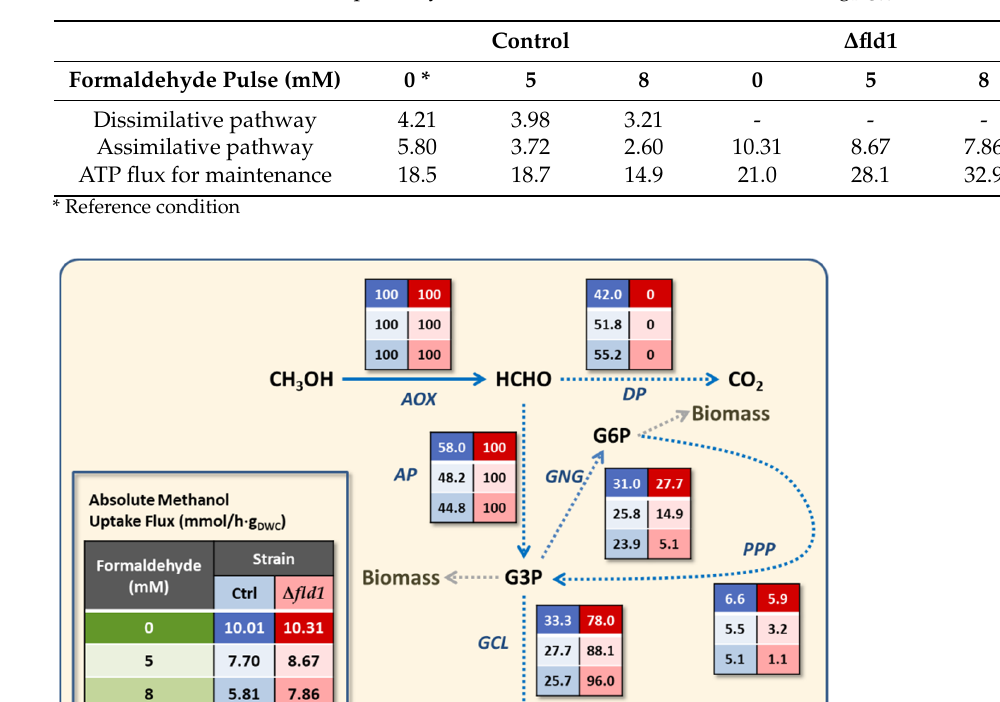
succinyl conezyme A; Mal: malate; OA: oxaloacetate. In order to confirm if the energy demand is increased by the lack of a dissimilative pathway, we have calculated the flux of ATP for maintenance by including the consump- tion and/or production of ATP (or GTP), NAD (P) H and FADH 2 in the metabolic reactions of the stoichiometric model. The estimation of the energy associated with maintenance has been used in several modelling approaches in yeast, including stoichiometric models to represent the metabolic processes that are occurring in the cell for viability and mainte- nance of homeostasis [18,20,28]. Results show that the ATP flux for maintenance was not affected by 5 mM formaldehyde pulses in the control strain, while a 20% reduction was observed after the 8 mM formaldehyde pulse (Table 3). In contrast, this flux was higher in the Δ fld1 strain compared to the control, and it increased even more after the formalde- hyde pulse to double the value of the control strain after the 8 mM formaldehyde pulse.